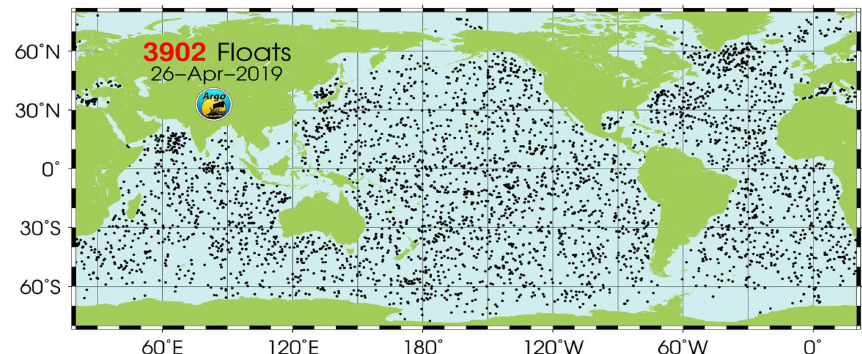
Figure 4. Argo global array of profiling floats: position of floats having delivered data within the last 30d until 26 April 2019. Source: © Argo programme (http://www.argo.ucsd.edu, last access: 26 April